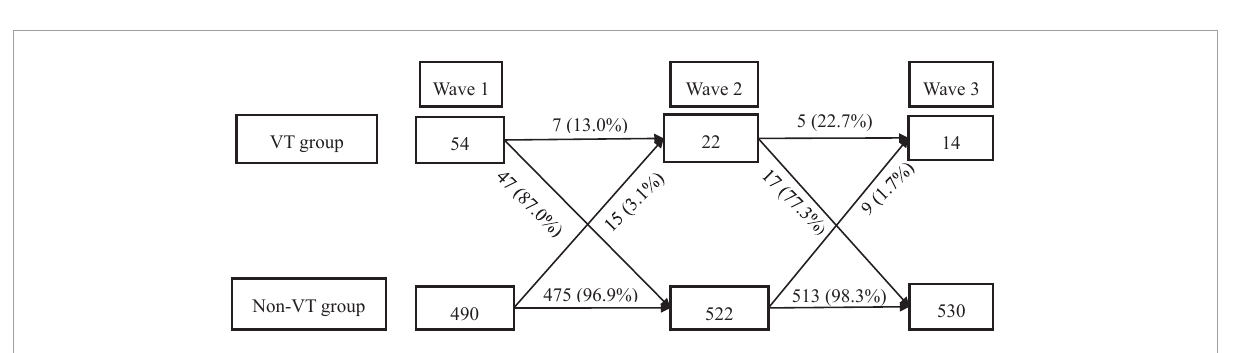
FIGURE3 Flow chart of the transformation of VT and non-VT in three-wave surveys.